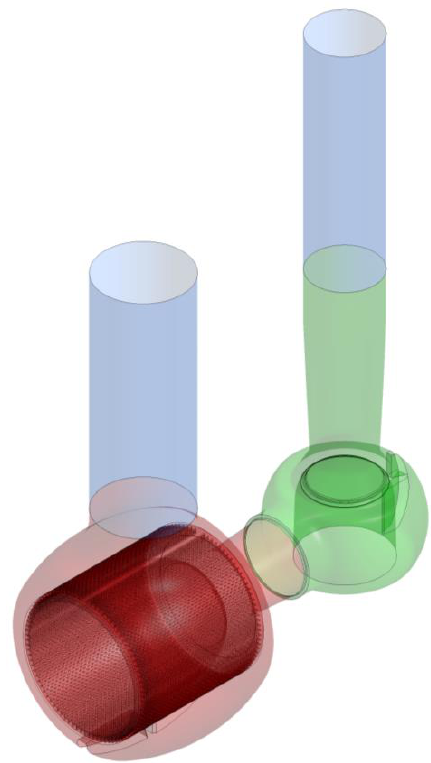
Fig. 4. Compact valve model assembly with the original control valve chamber .